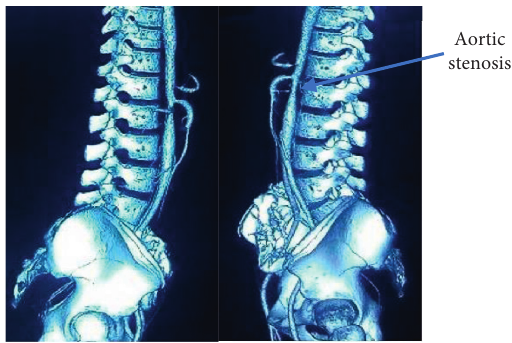
Figure 3: CTA showing aortic stenosis at L2